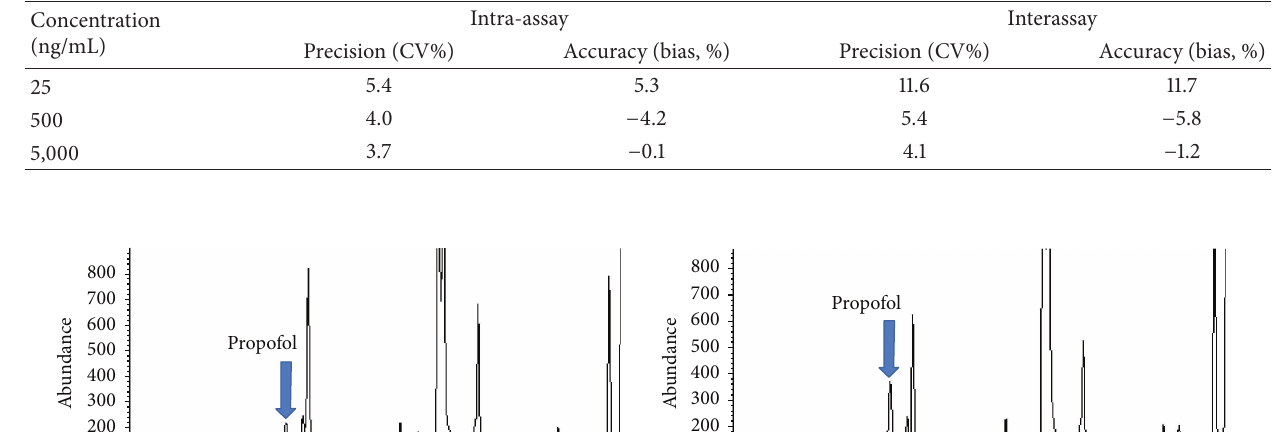
Table 1: Intra- and interday precision and accuracy of propofol.